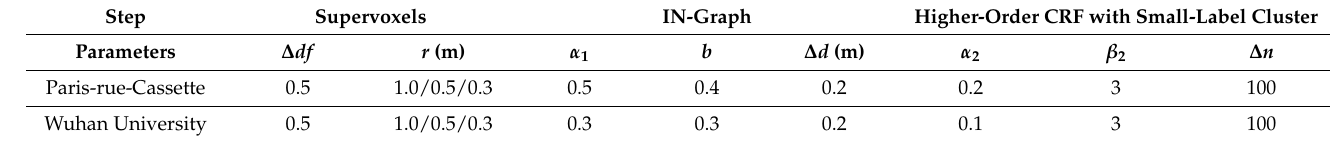
Table 3. Parameter settings for two datasets.